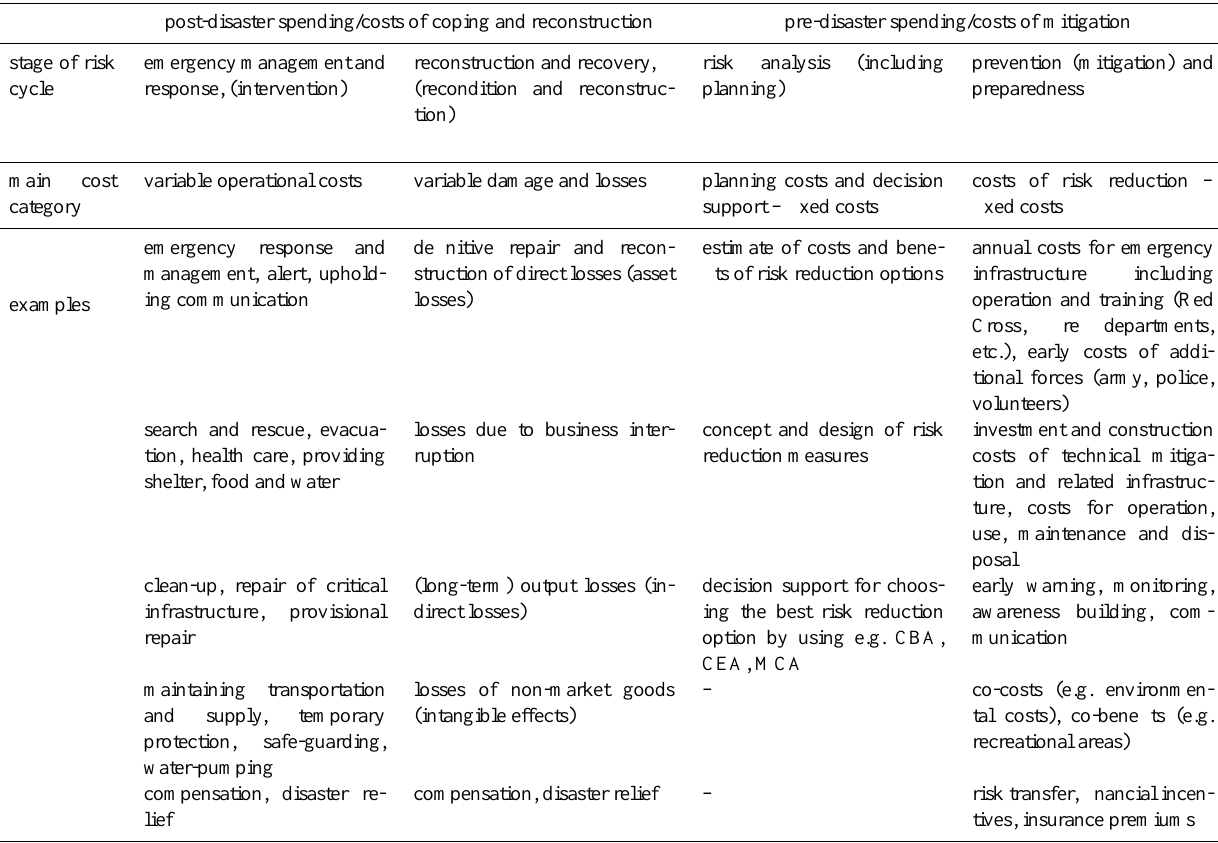
Table 1. Overview of cost types occurring at different stages of natural hazards; based on concepts of Kienholz et al. (2004) and The World Bank (2010).